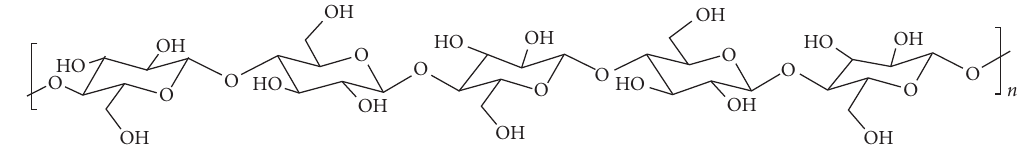
Figure 3: Chemical structure of cellulose molecule